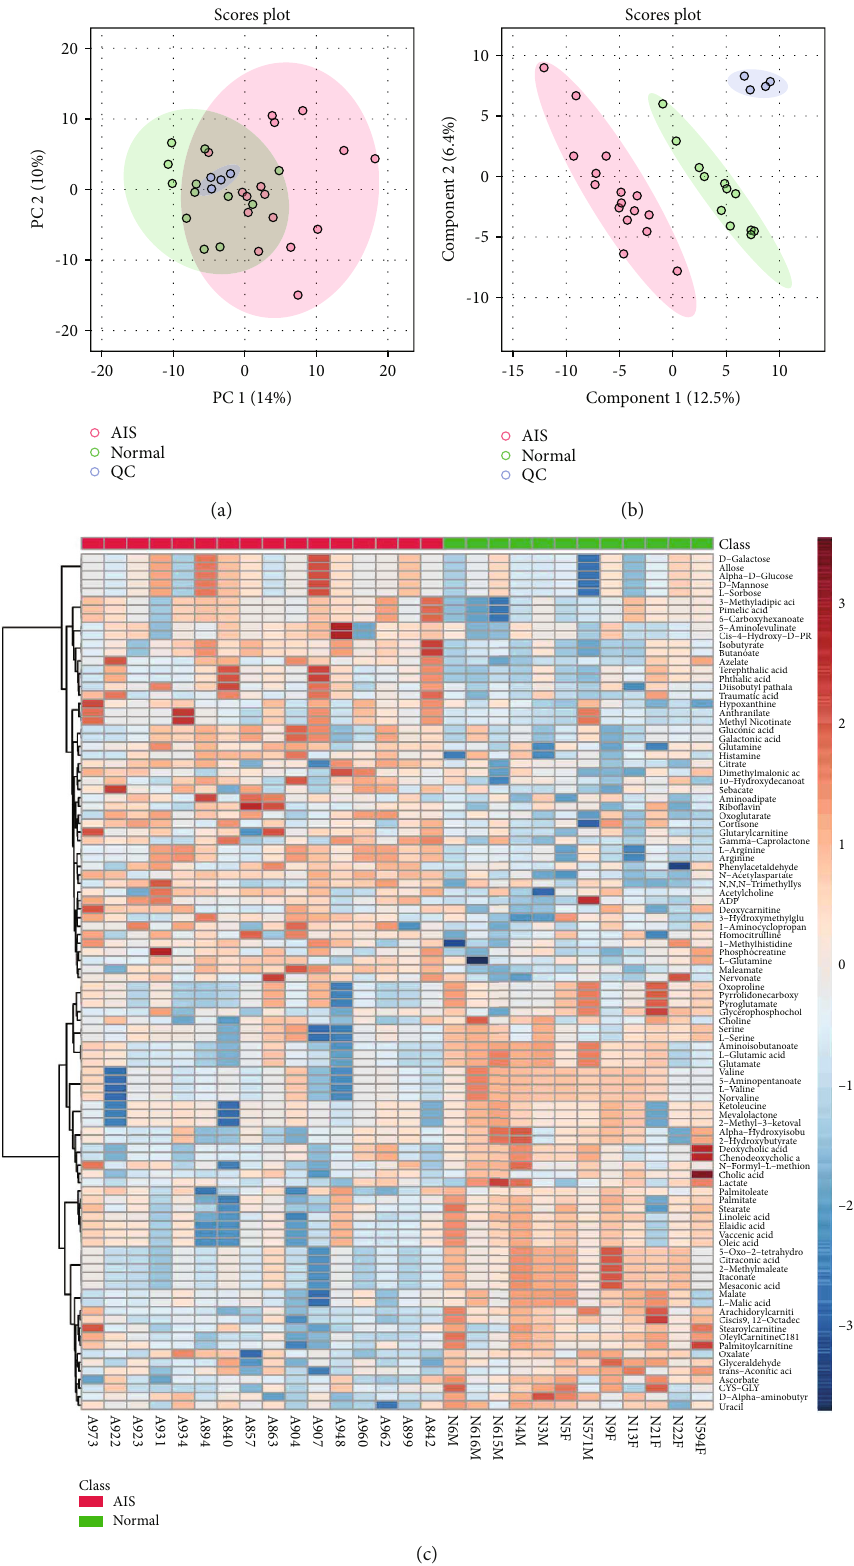
Figure 1: The analysis of plasma metabolite pro fi les. (a) PCA was used to analyze the degree of dispersion of samples in the quality control and healthy and AIS groups. (b) PLS-DA was used to analyze the degree of dispersion of samples in the quality control and healthy and AIS groups. (c) Heatmap shows the distribution of the top 100 metabolites among di ff erent